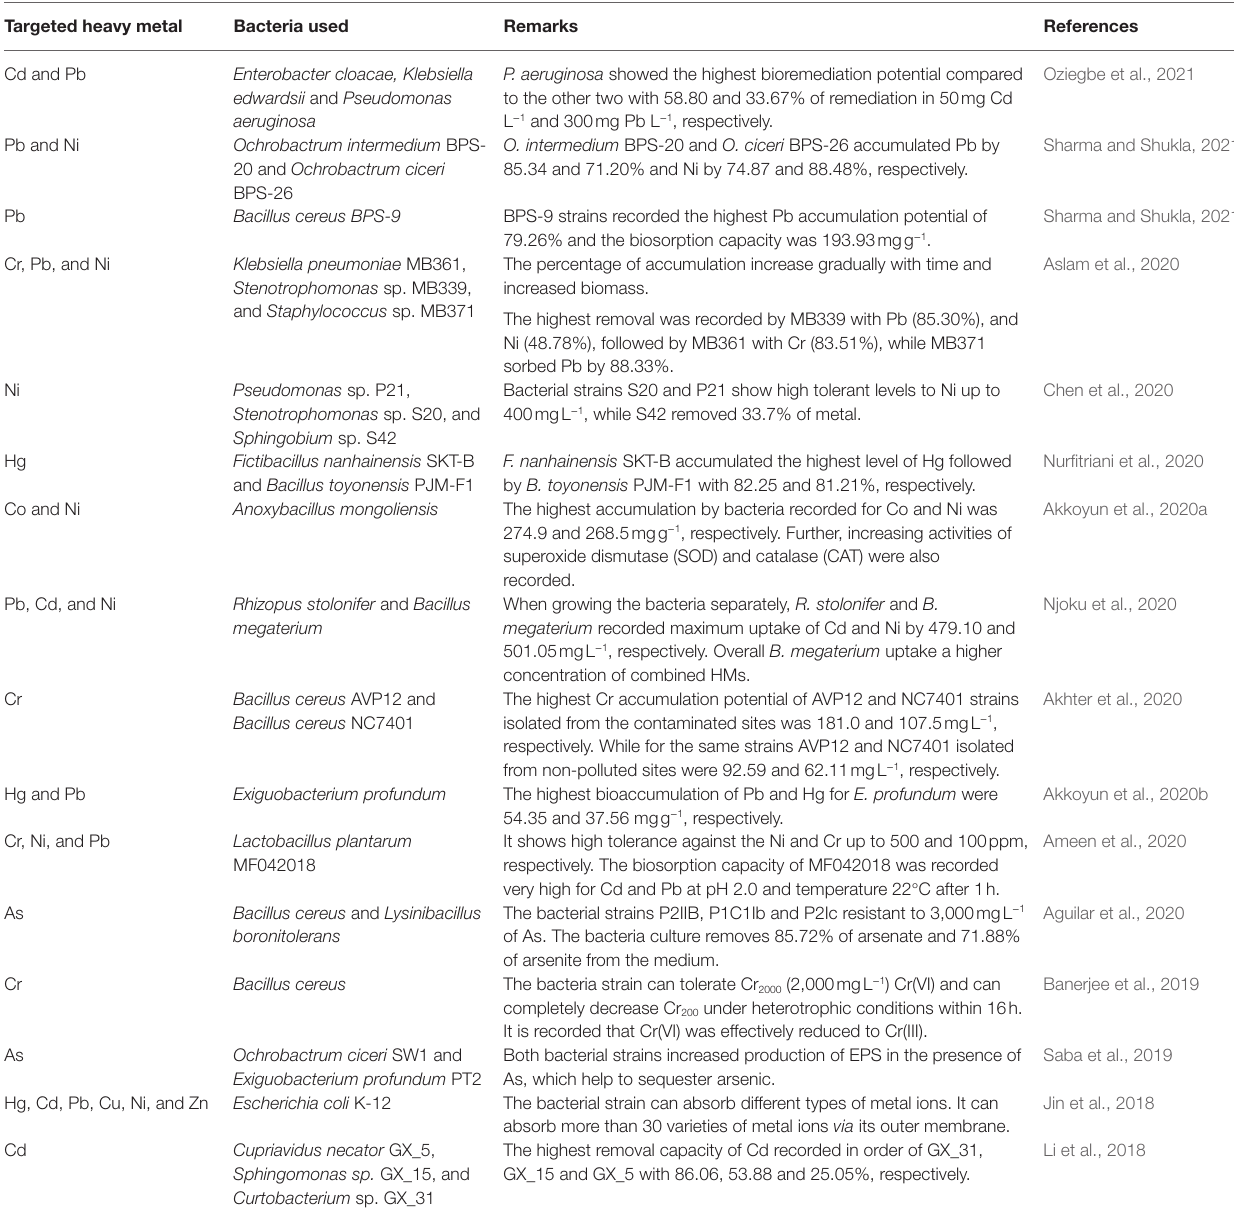
TABLE 3 | Metal bioremediation potential of bacteria